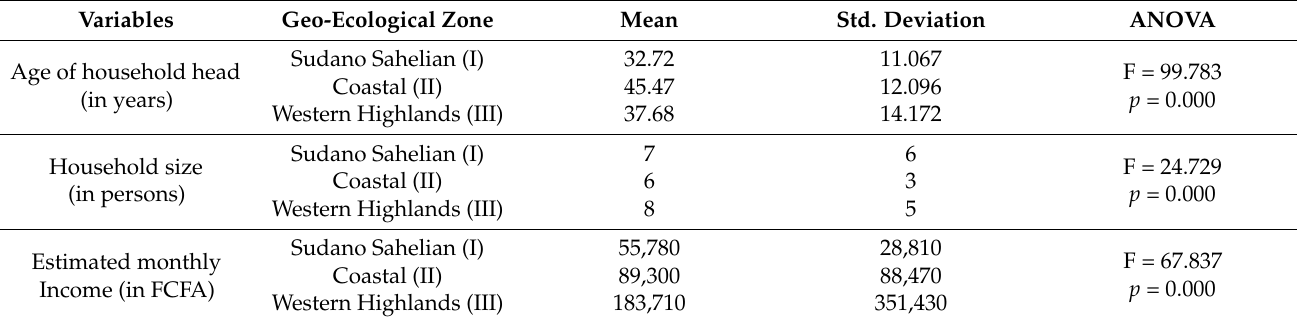
Table 1. Demographic characteristics of households by geo-ecological zone.